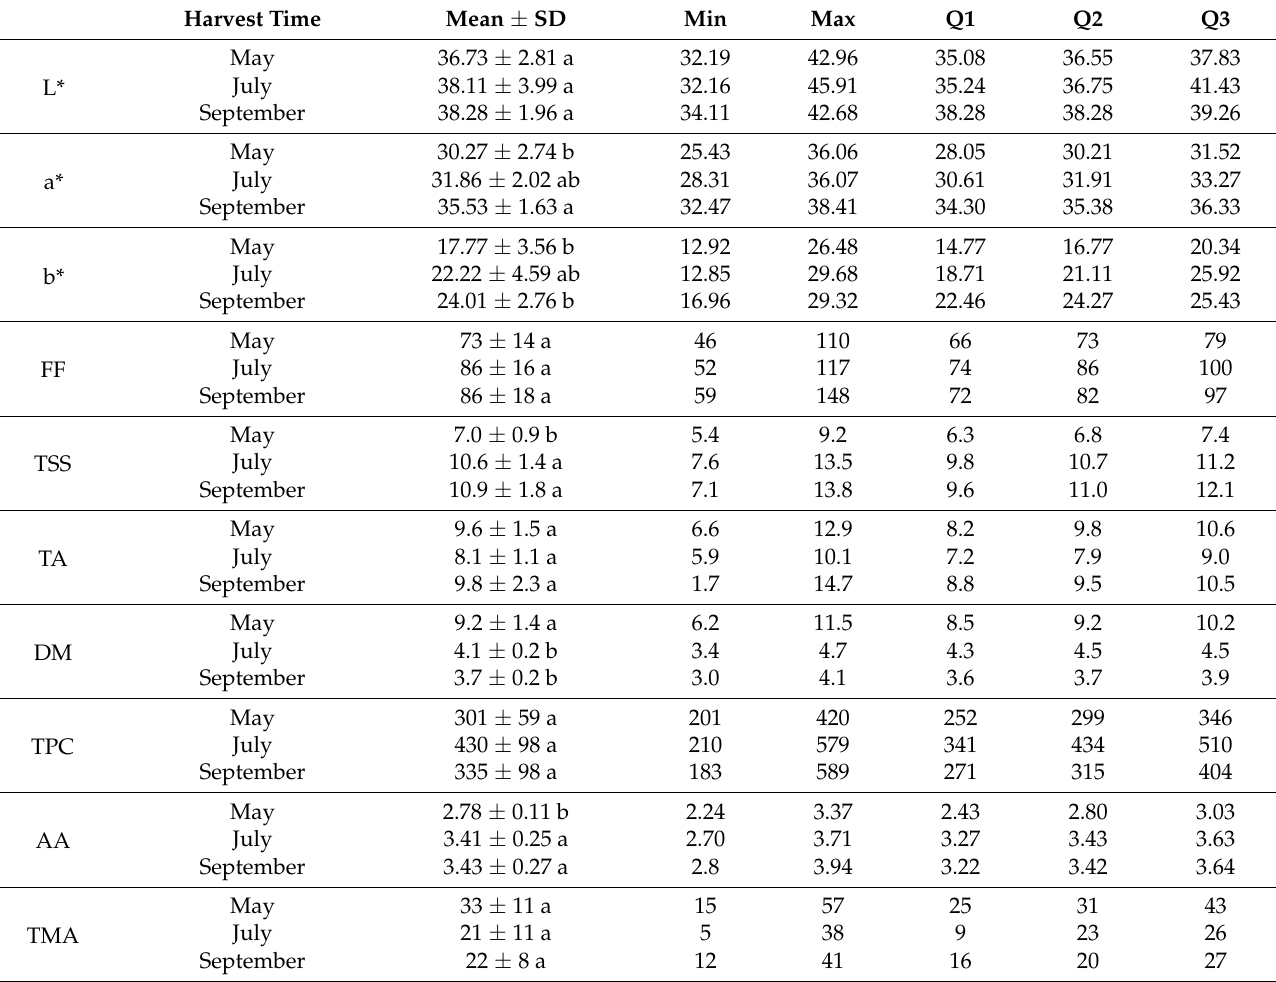
Table 2. Means data, standard deviation (SD), minimum (Min), maximum (Max), 25th percentile (Q1), median (Q2), and 75th percentile (Q3) value of strawberries quality parameters divided by harvest